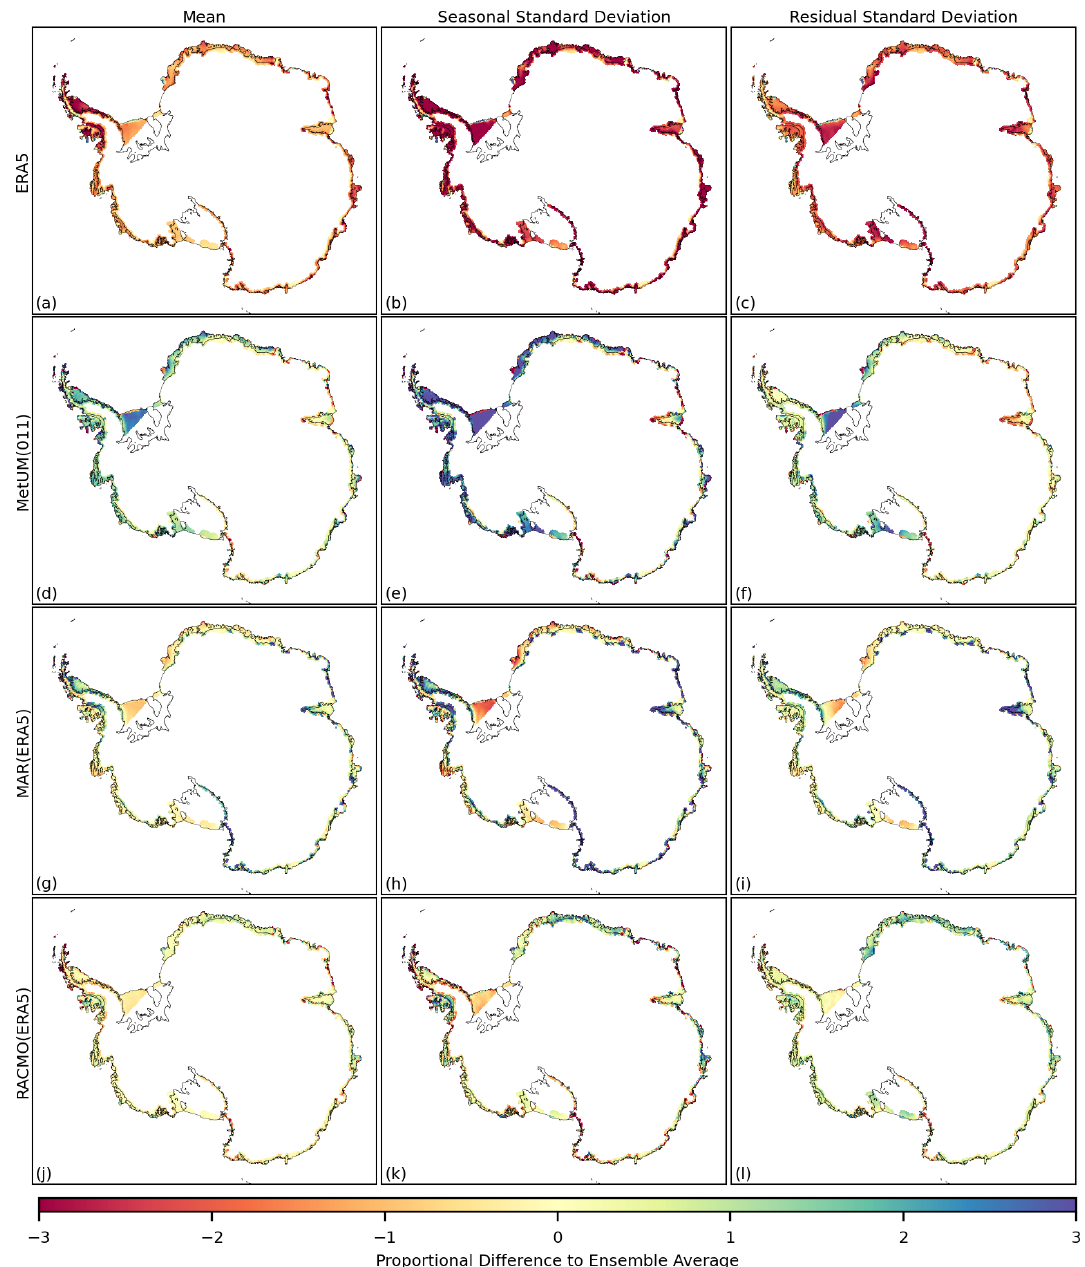
Figure 6. The difference to the ensemble average (model-ensemble avg) for the 1981–2018 time series of melt, in the mean (a, d, g, j) , the standard deviation of the seasonal component (b, e, h, k) and the standard deviation of the residual component (c, f, i, l) . The ensemble includes ERA5 (a–c) , MetUM(011) (d–f) , MAR(ERA5) (g–i) and RACMO(ERA5) (j–l) . Differences at each grid cell are expressed as a proportion of average inter-annual variation and so do not have units. Grid cells where the ensemble mean average monthly melt is less than 1mmw.e. per month are